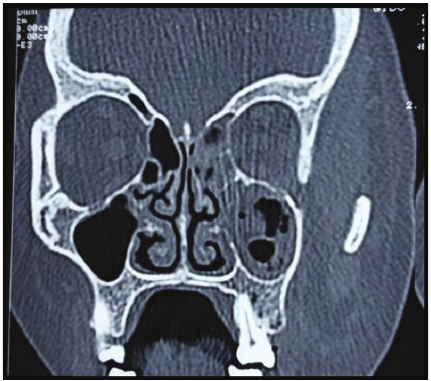
Figure 4: Coronal view of CT showing involvement of left maxillary sinus, nasal conchae, and ethmoidal sinus extending up to frontal sinus.